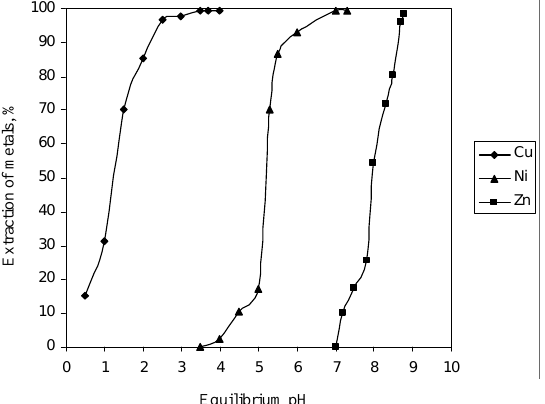
Figure 1. Influence of Equilibrium pH on the extraction of metals Aqueous phase: 0.0025 M each of Cu(II), Ni(II) and Zn(II). Organic phase:0.005 M LIX 984N. Contact time: 20 min. Temperature: Room temperature